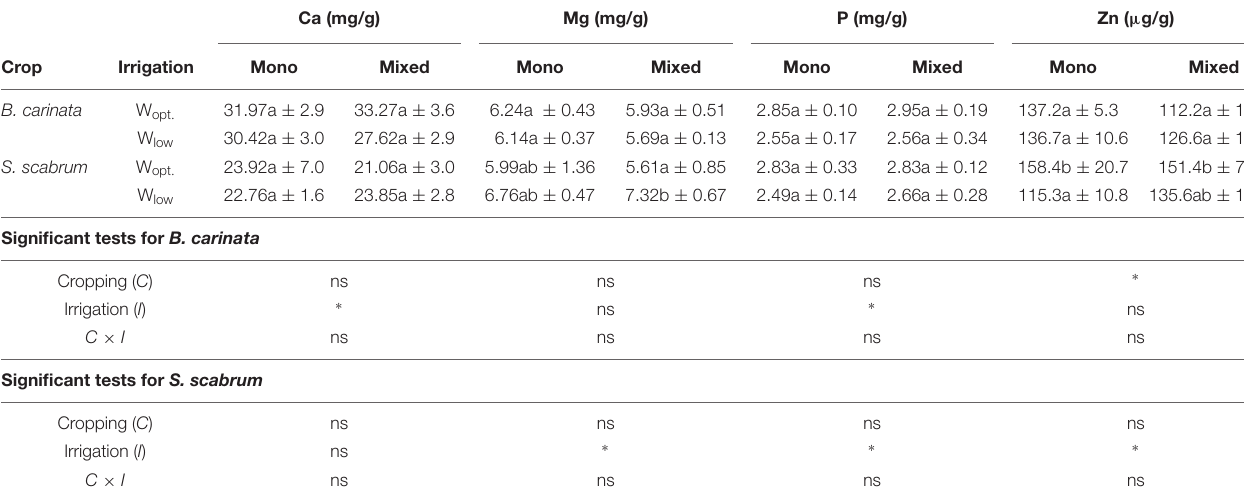
Shoot dry weight